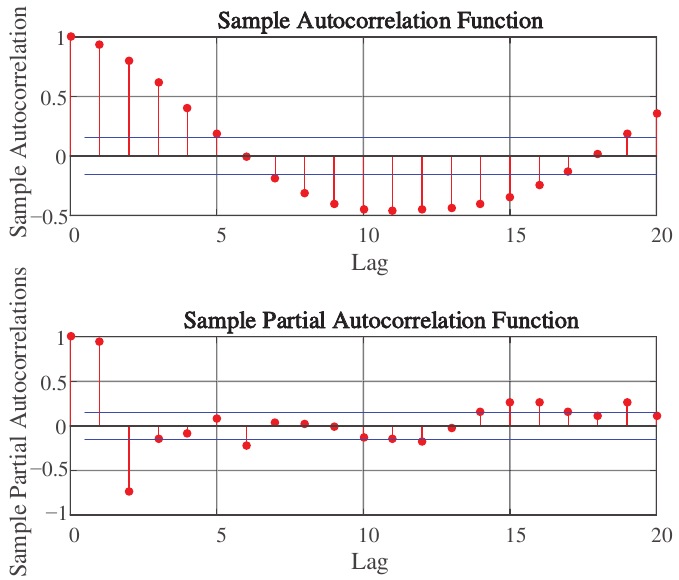
Figure 3. The ACF/PACF chart of time series.